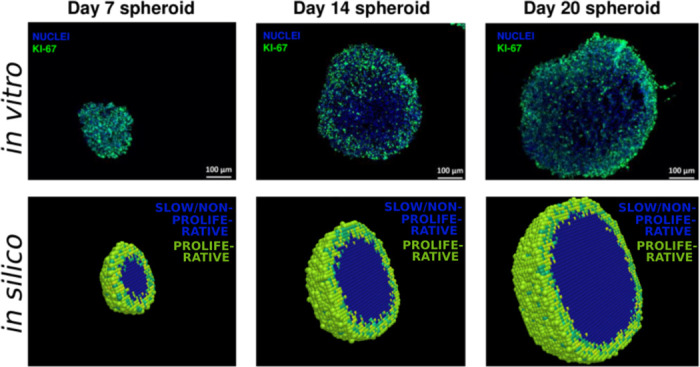
Proliferative and slow-cycling or non-proliferative cells.Top: Images from in vitro experiments performed by Voissiere et al. [35], in which cell nuclei are stained blue and proliferative cells are stained green by the proliferation marker Ki-67. Bottom: Images from in silico experiments performed in this study, where proliferative (cycling) cells are coloured green and inner (slow-cycling or non-proliferative) cells are coloured blue.